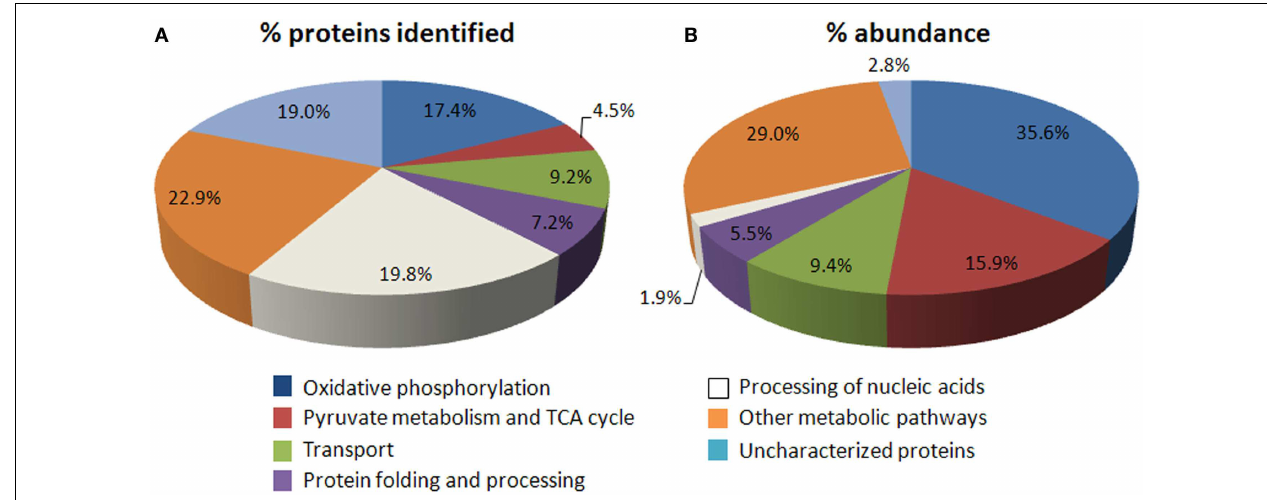
been found (Schmidt et al., 2010). In addition, more proteins are involved in mitochondrial genome maintenance (white) in plants ( ∼ 20%) than in yeast ( ∼ 12%), due to the presence of numerous plant-specific pentatricopeptide repeat (PPR) proteins and a larger genome size. (B) Distribution of the abundance of proteins that can be identified by gel-free MS (Taylor et al., 2011) across seven functional